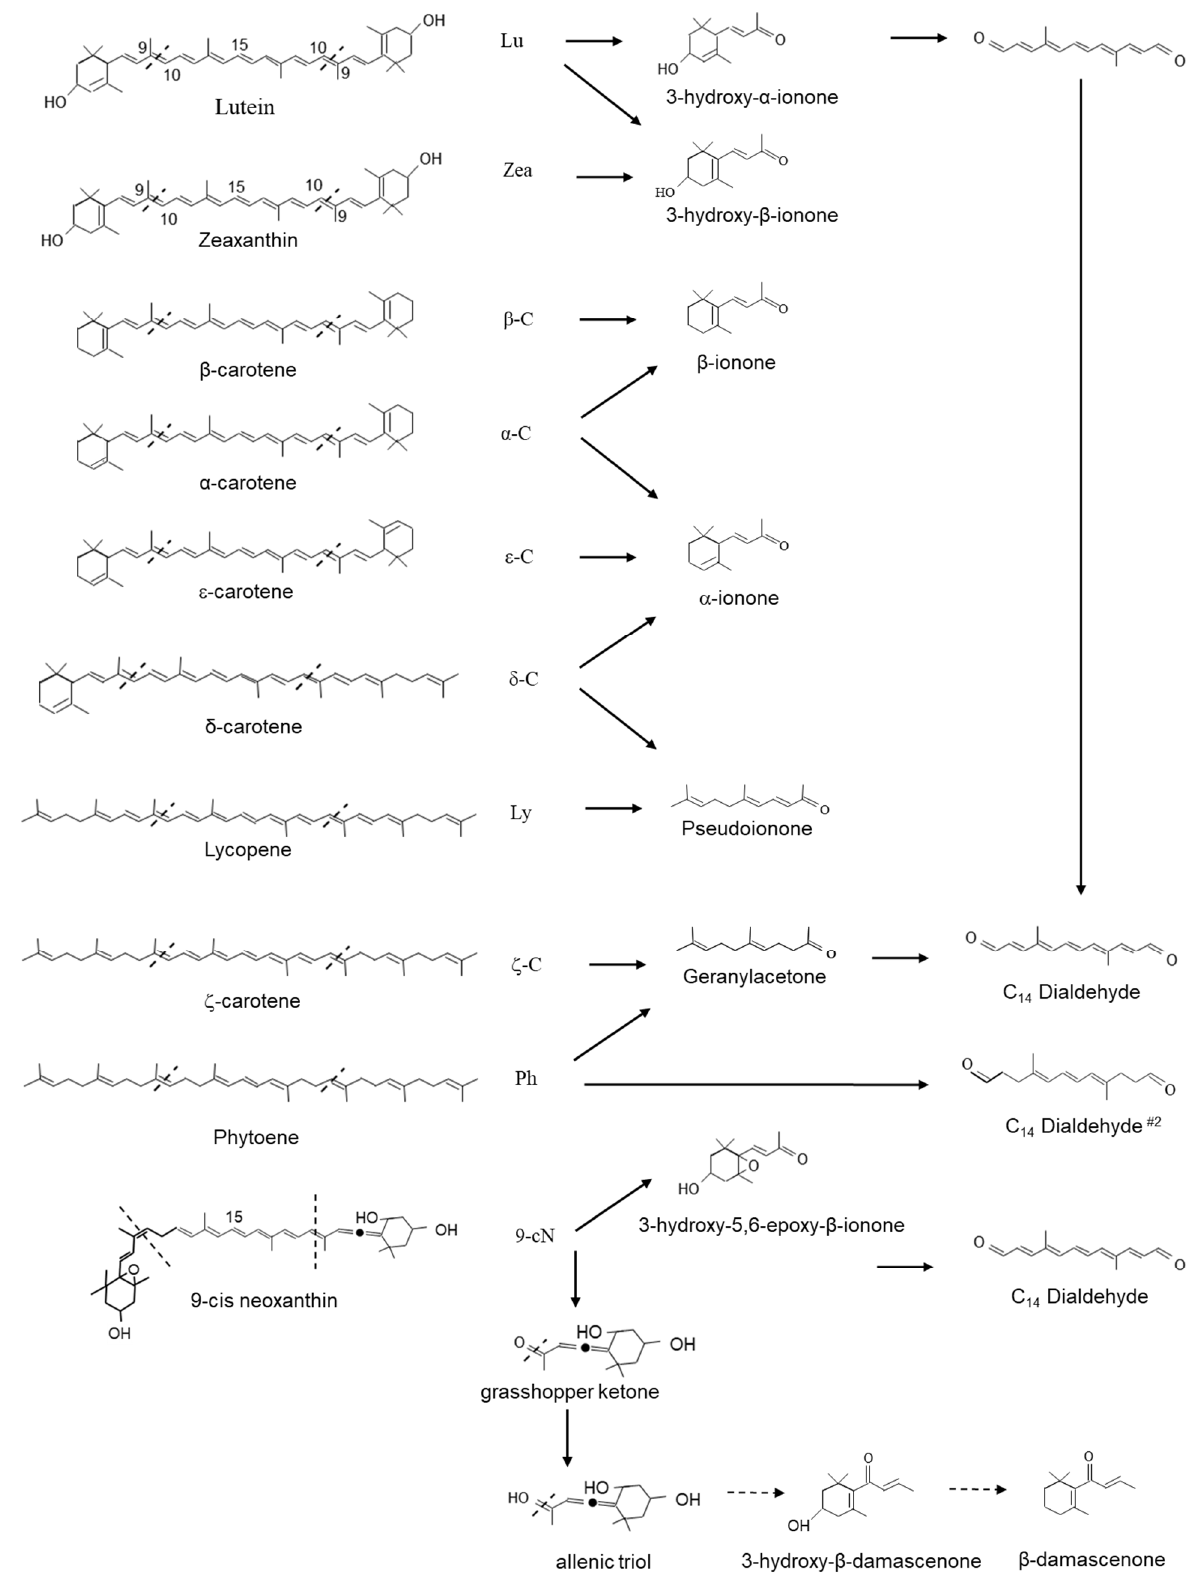
Figure 4. Scheme for the 9,10(9 ′ ,10 ′ ,) reactions catalysed by the recombinant CCD1 proteins with various substrates. C 14 rosafluene-dialdehyde (4,9-dimethyldodeca-2,4,6,8,10-pentaene-1,12-dial). CCD1 activities are carried out in the cytosol.